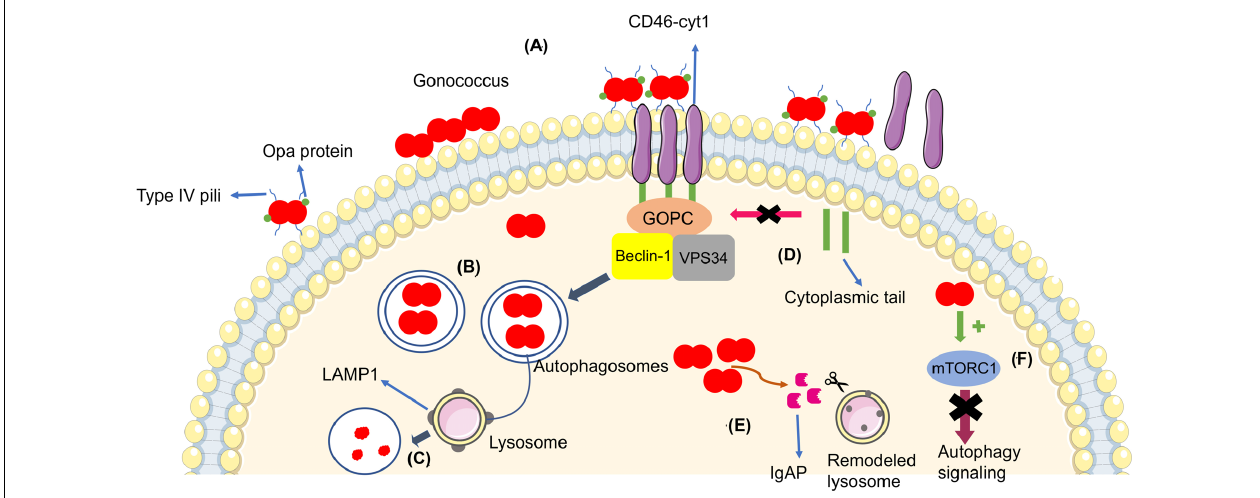
FIGURE 1 | (A) Gonococci (in red) adhere to the cellular membrane and form a microcolony, triggering the autophagy pathway through CD46-cyt1/GOPC, which recruits the Beclin-1/Vps34 complex. (B) Bacteria become enveloped in the autophagosome (blue arrow). (C) The autophagosome fuses with the lysosome in order to kill the bacteria. (D) Gonococci evade the autophagy pathway by inducing the cleavage of the CD46-cyt ectodomain via metalloproteinases and by inducing the cleavage and release of the cytoplasmic tail via presenilin/y-secretase, decreasing intracellular CD46-cyt1 and the cell’s ability to initiate autophagy (pink arrow). (E) Bacteria secrete IgAP, (orange arrow) which cleaves LAMP1, resulting in remodeling of the lysosomal membranes and prevention of autophagosome/lysosome fusion, therefore increasing the survival of the gonococci. (F) Gonococci activate mTORC1 (green arrow), therefore suppressing autophagy signaling (purple